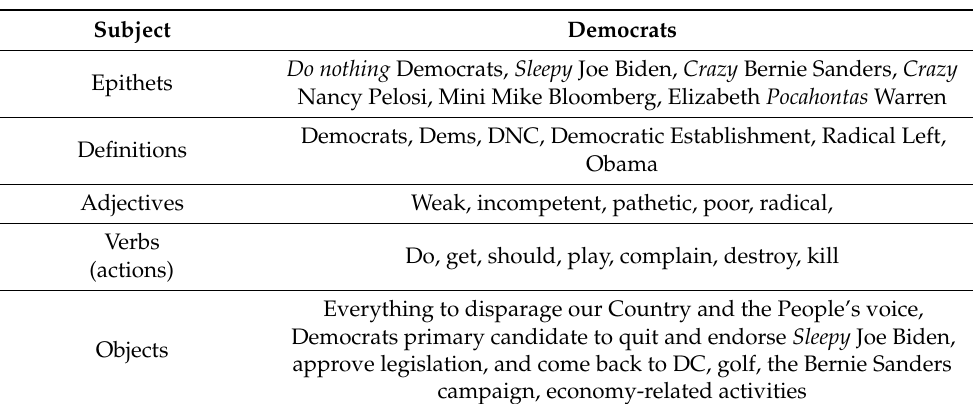
Table 4. Democratic